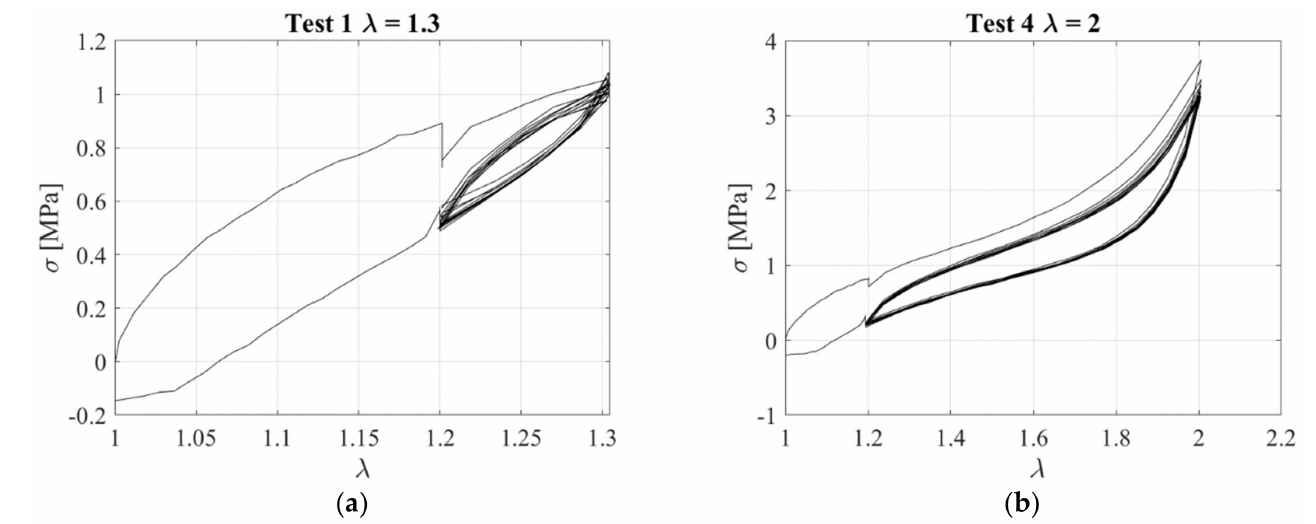
Figure 10. Stress − extension curve for Test 1 ( a ) and Test 4 ( b